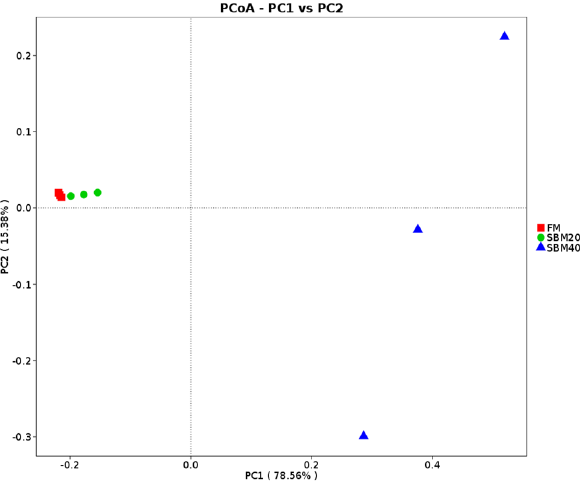
Figure 4. PCoA analysis of intestinal microflora of pearl gentian grouper fed by different levels of soybean meal (n =